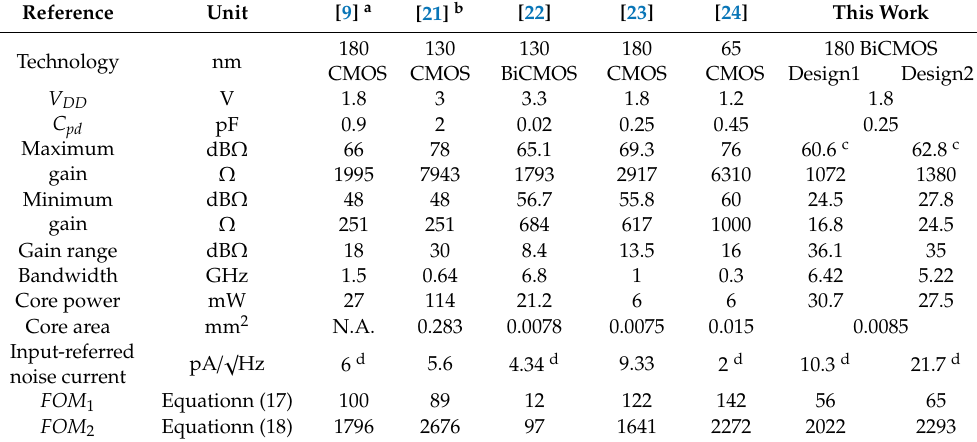
Table 5. Table of comparison with other recent